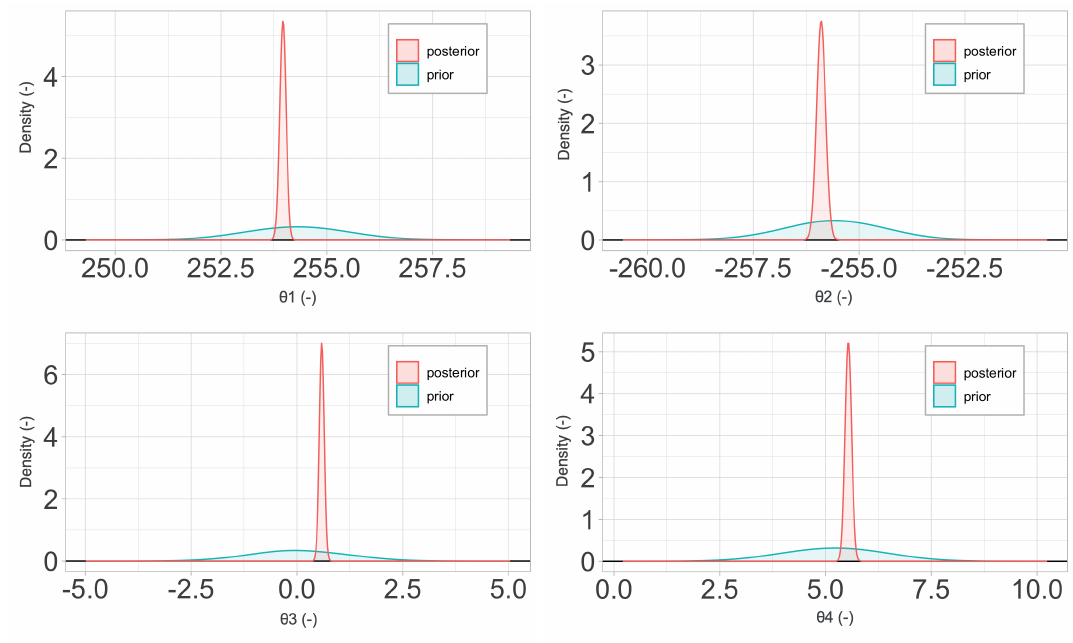
Figure 18. Prior vs. posterior parameter probability distributions for parameters A 2 ∼ θ 1 , A 3 ∼